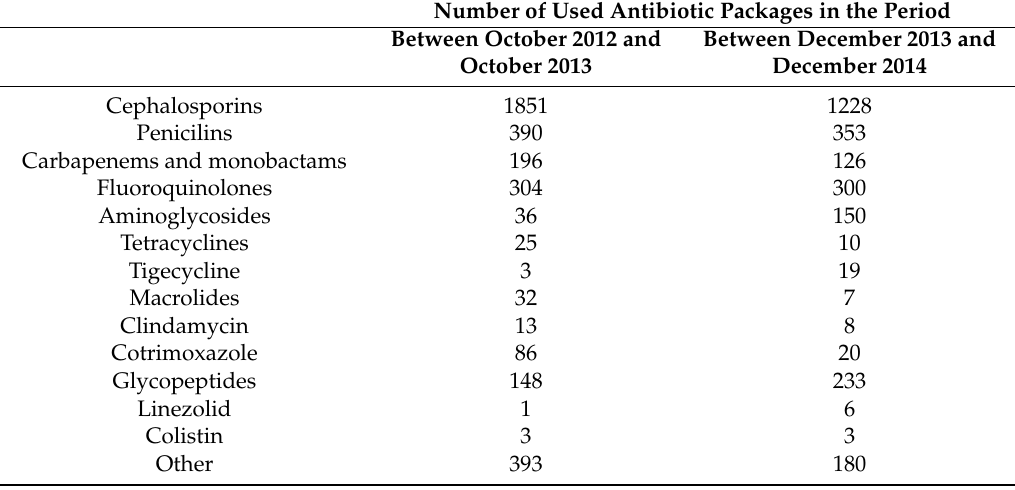
Table 6. Number of used antibiotic packages in the Department of Nephrology, Transplantation